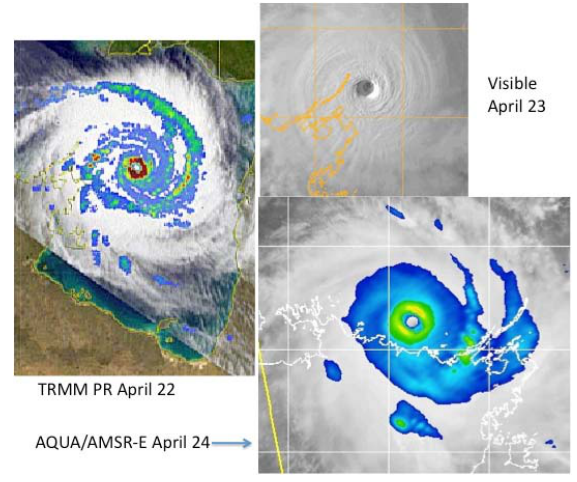
Figure 2 . Selected imagery of Cyclone Monica. (a) TRMM Precipitation Radar image at 1608 UTC on 22 April 2006. Maximum rain rate (dark red) exceeds 50 mm/h. (b) Visible imagery at 0900 UTC on 23 April 2006. (c) 85 GHz PCT image of Monica from NASA Aqua/AMSR-E at 0430 UTC on 24 April, overlaid on visible imagery. Yellow in eyewall is ~160 K. Courtesy US